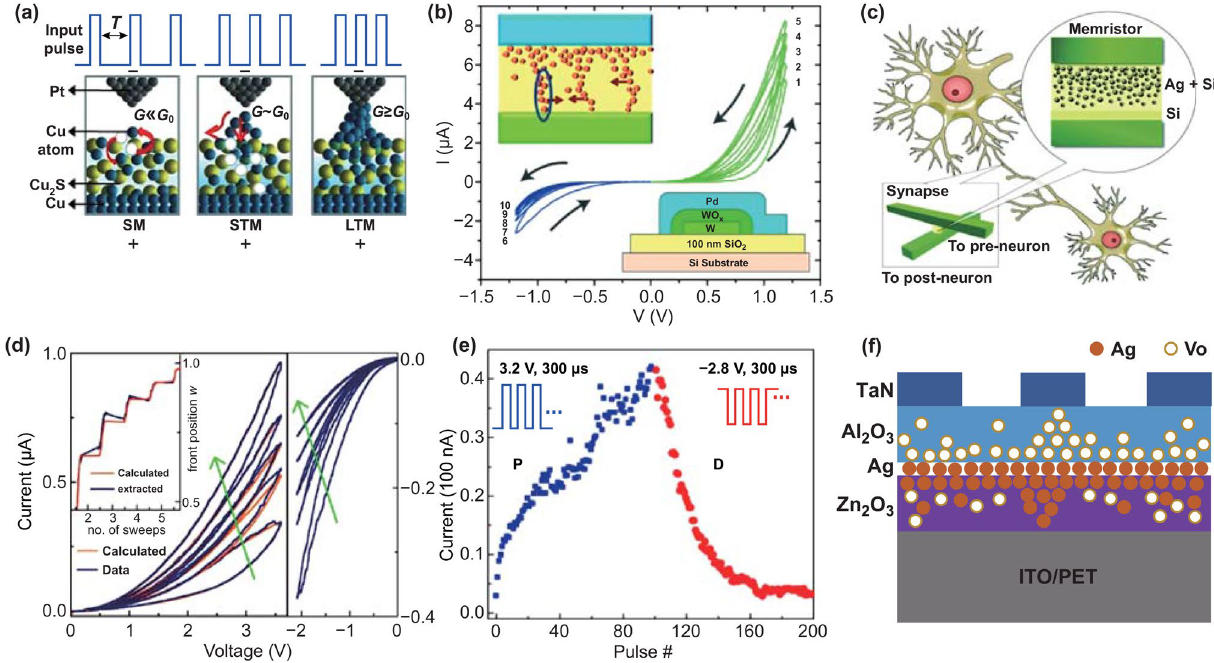
Fig. 2 a Atomic-switch-based synaptic devices. Reproduced with permission from Ref. [43]. b Changes in conductance versus the increase in the sweep number of oxygen vacancy (or oxygen ion) diffusion-based synaptic device. Reproduced with permission from Ref. [47]. c Schematic of Ag-migration-memristor-based synapse device. d Measured (blue lines) and calculated (orange lines) I–V characteristics of the memristor. Inset: calculated and extracted values of Ag front position w versus the number of sweeps. e Current values of the devices in response to external potentiation and depression pulses. c – e Reproduced with permission from Ref. [61]. f Schematics of the device structure and the corresponding mechanism. Adapted from Ref.